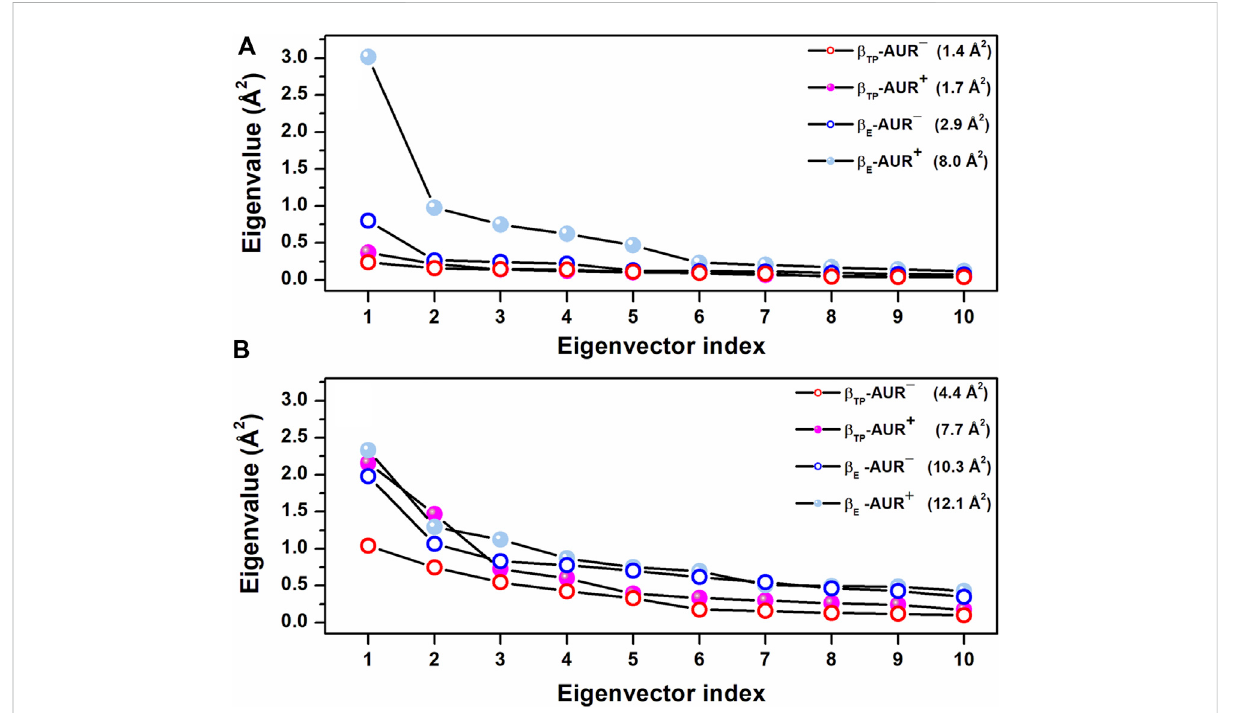
FIGURE 7 Scree plots obtained from dPCA for nucleotide binding residues in β TP . (A) Backbone dihedral angles. (B) Side chain dihedral angles. The eigenvalue distributions for the fi rst ten eigenvectors are shown. The values in parentheses indicate the total variance for the corresponding system. Residues with χ angles within 5 Å of the nucleotide in β TP (V 160 -V 164 , R 189 , T 190 , R 260 , Y 311 , Y 345 , P 346 , Q 416 , F 418 , F 424 , T 425 ) were included in the